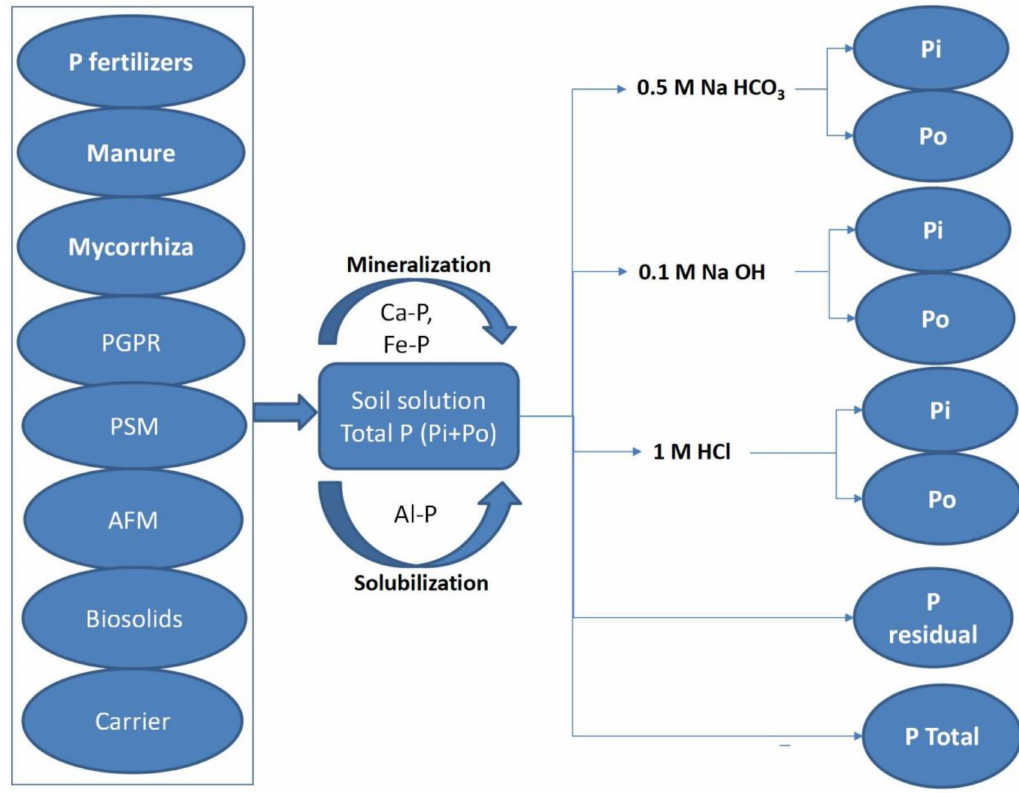
Figure 2. Inspired strategies for managing phosphorus and its